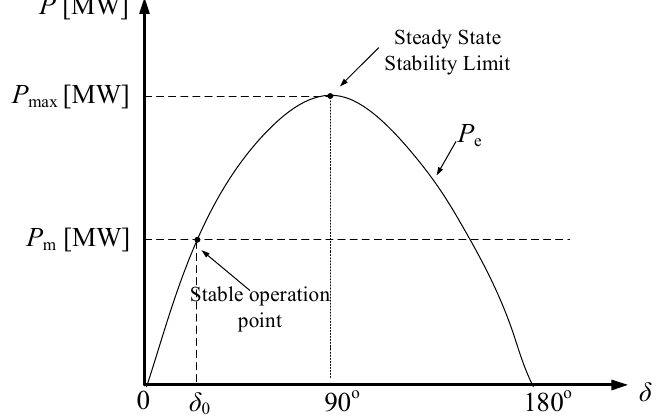
Figure 8. The relationship between 𝑃 (cid:3040) and 𝑃 (cid:3032)